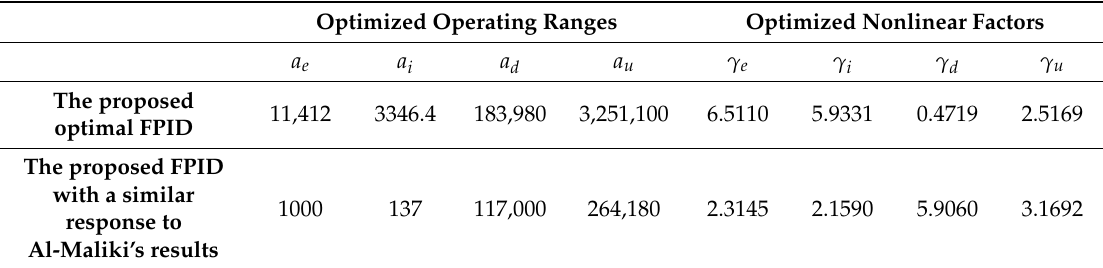
Figure 19. The motor speed input and system responses. Table 7. The eight optimized parameters.